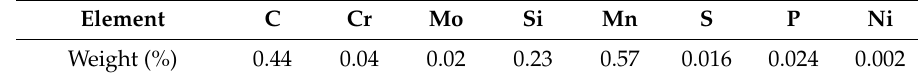
Table 1. Chemical composition of the material. Table 2. Mechanical properties of the material with the different tempering temperature.